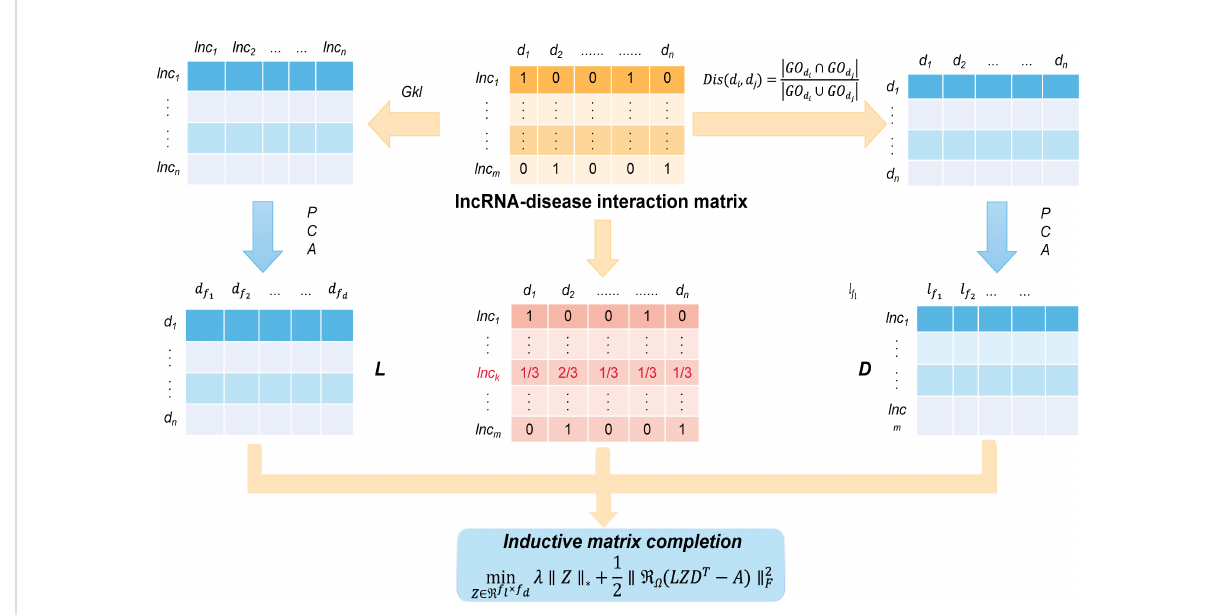
FIGURE 3 The work fl ow indicates that SIMCLDA predicts potential lncRNA – disease associations based on inductive matrix